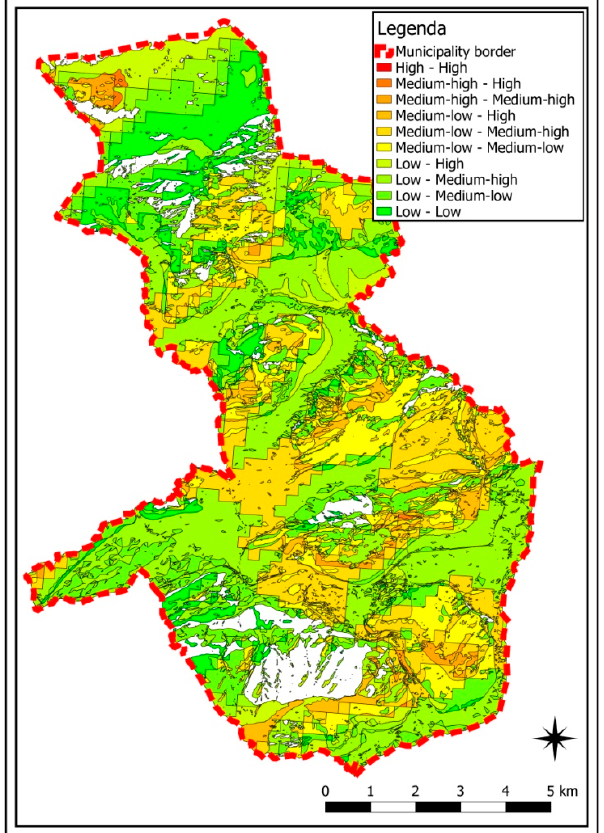
Figure 22. Extreme event susceptibility map combining susceptibility to wind damage and land ‐ slides.